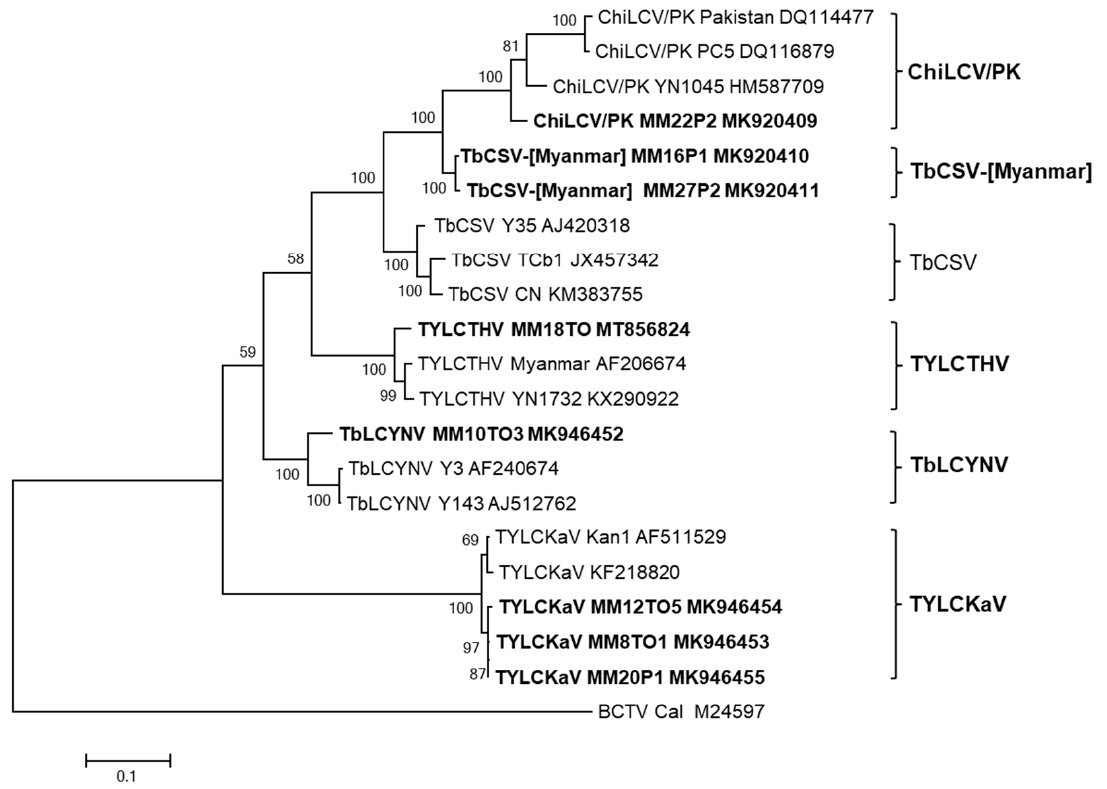
Figure 2. Phylogenetic analysis based on the complete nucleotide sequences of monopartite or DNA-A of eight begomovirus isolates from pepper and tomato plants in Myanmar and the corresponding sequences of begomoviruses previously reported in GenBank. The phylogenetic tree was reconstructed by maximum likelihood in MEGA X using the TN93+G model. The bootstrap values are indicated at the nodes (based on 1000 replicates). Viruses isolated in this study are shown in bold font. The tree was rooted using Beet curly top virus (BCTV: accession no. M24597) as an outgroup.